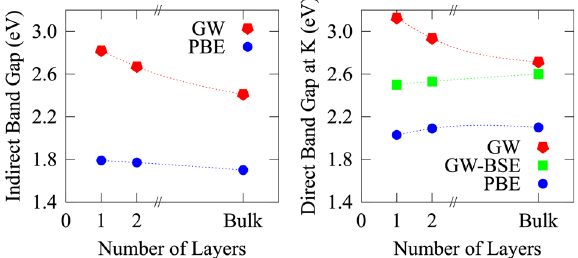
Fig. 6 Layer-dependent band gap results of MoSi 2 N 4 . Evolution of the indirect minimum band gap (left panel), the direct band gap at the K point and the optical gap (right panel) as a function of the number of layers calculated at different theory